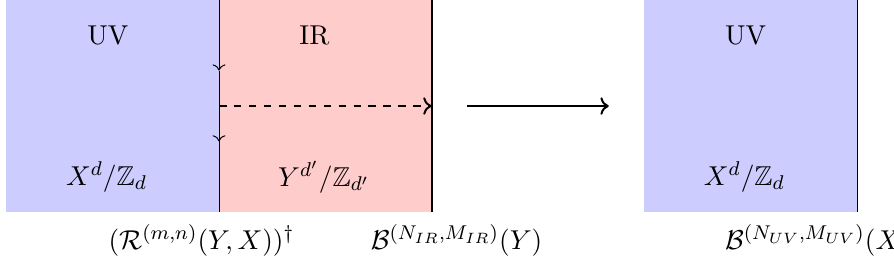
Figure 5 . Setup for the composition R † ∗ orb B IR = B UV